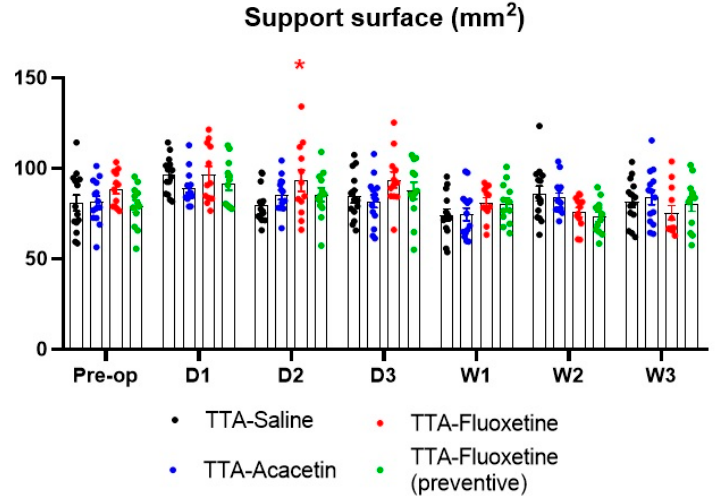
± SEM; statistically